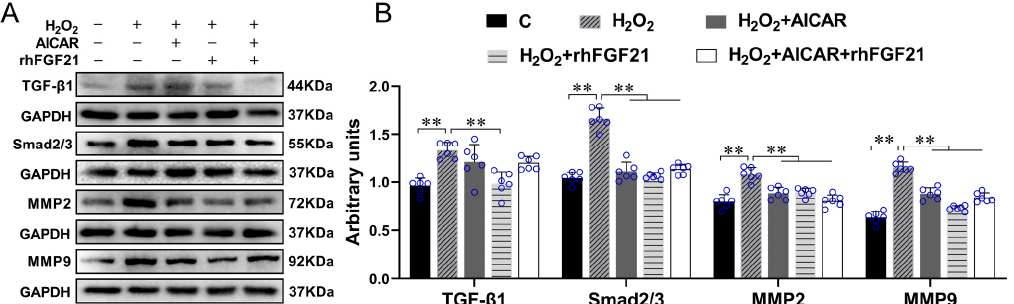
Figure 3. rhFGF21 and/or AICAR inhibited the activation of the TGF- β 1-Smad2/3-MMP2/9 signaling pathway in CFs with H 2 O 2 treatment. ( A ) The protein expressions of TGF- β 1, Smad2/3, MMP2, and MMP9 in CFs. ( B ) Statistical analysis. Data are expressed as mean ± Standard Deviation (SD), n = 6. Statistical method: one-way analysis of variance (ANOVA). ** p < 0.01. rhFGF21, Recombinant human FGF21; AICAR, 5-Aminoimidazole-4-carboxamide ribonucleotide; CFs, cardiac fibroblasts; C, Untreated control group.